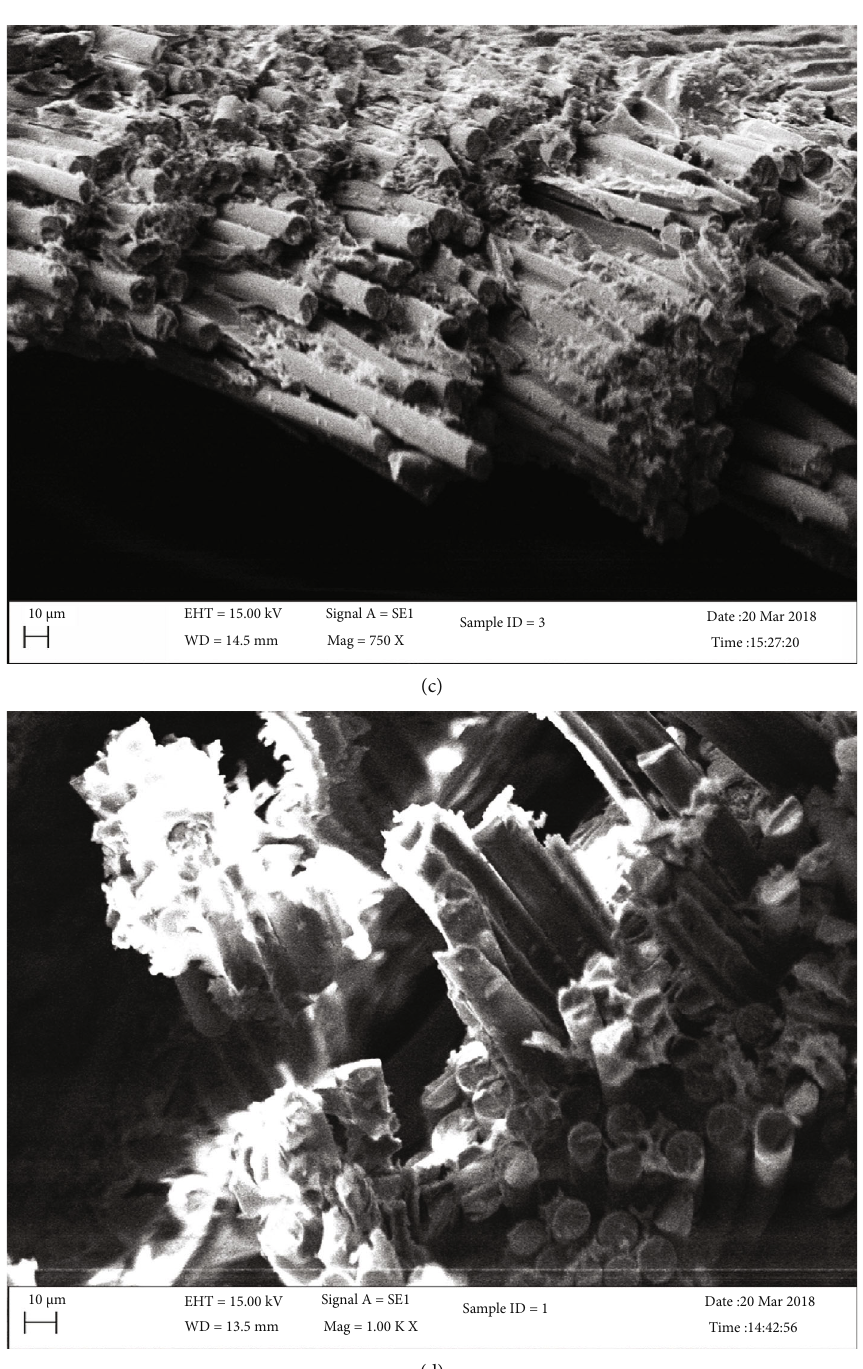
Figure 8: Scanning electron microscopic images of basalt fi ber – reinforced with anamide composites. (a) Fiber pull out at 0o orientation. (b) Fiber resin bonding. (c) Fiber resin bonding at higher magni fi cation. (d) Fiber debonding at 45o